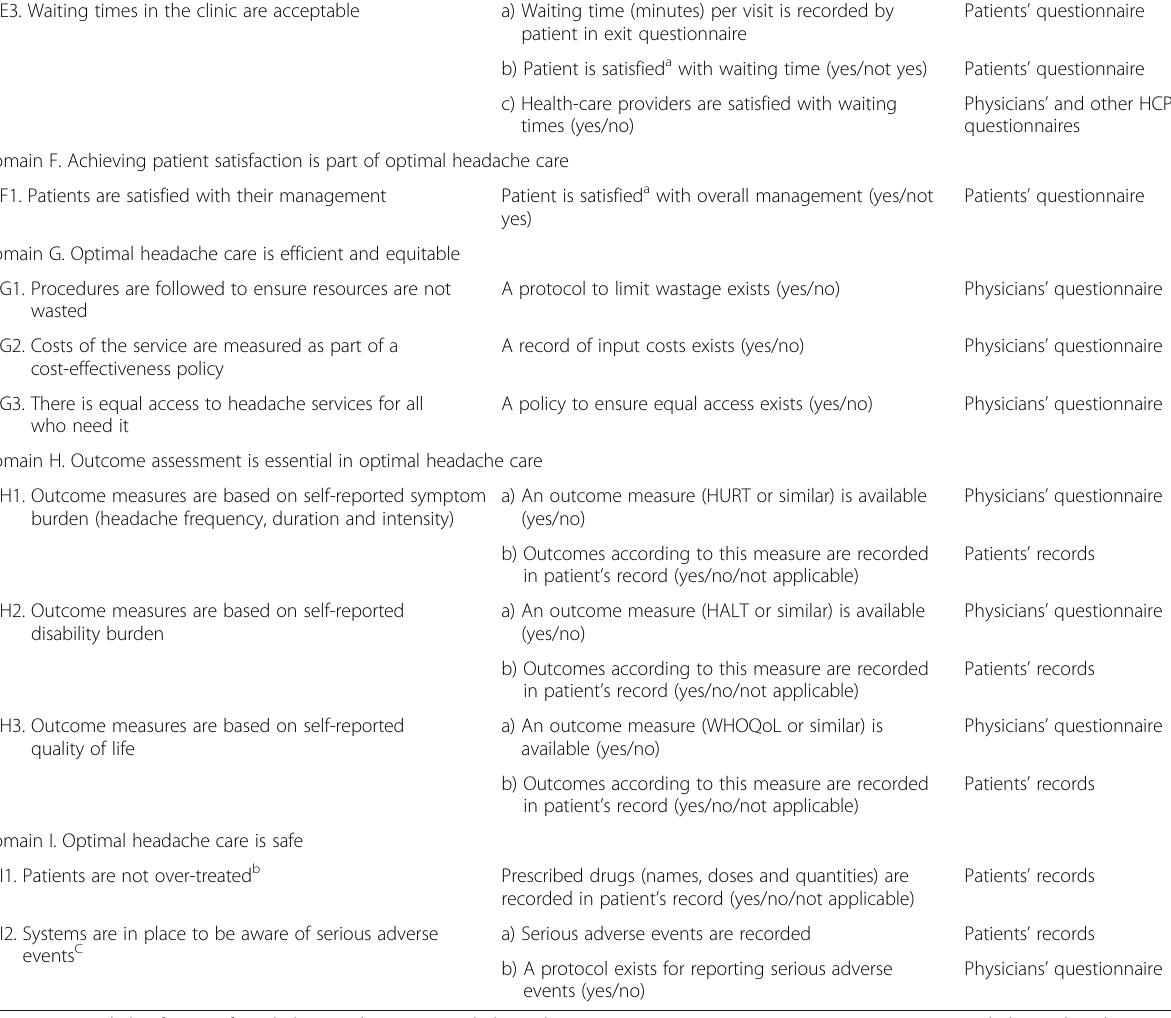
Table 2 Methods of implementation of service quality indicators